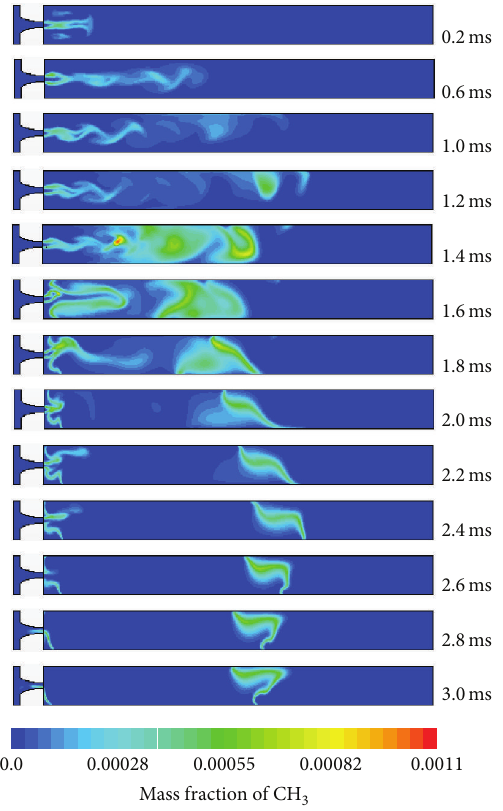
Figure 12: CO mass fraction during methane-air combustion predicted using DRM19